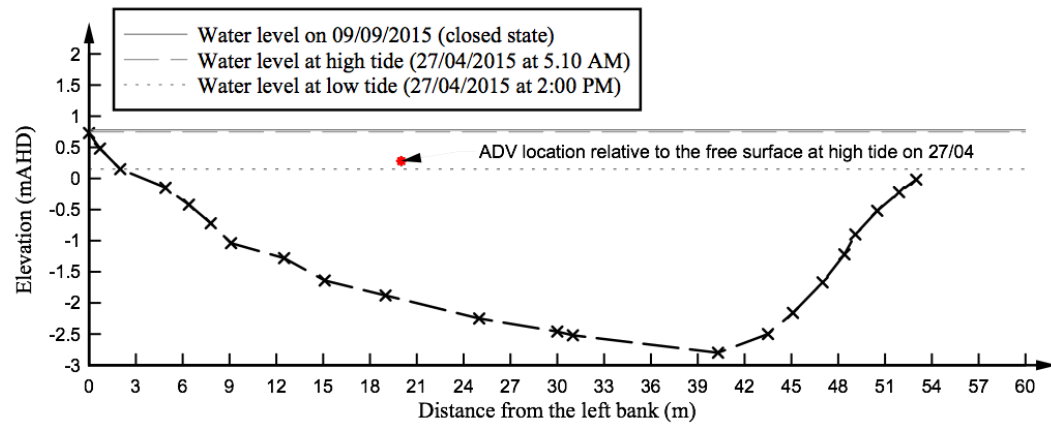
Figure 3. Surveyed cross-section, next to the pontoon (Figure 1b), conducted during the closed state (E2) (9 September 2015) facing downstream; location of ADV during the open state (E1) relative to the free surface is shown.